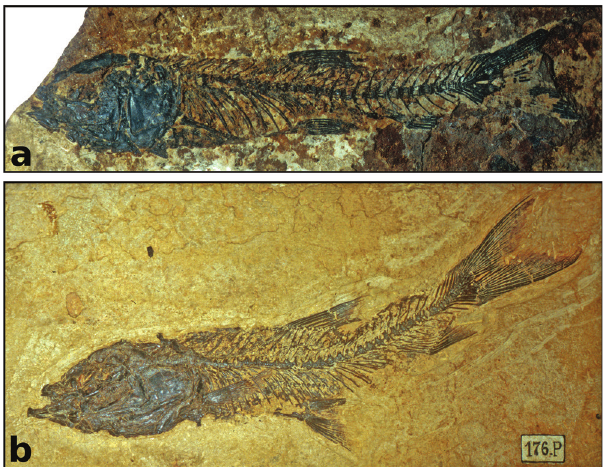
Fig. 2 . a . Dastilbe moraesi , DGM 593-P, 47.0 mm SL, holotype, Fazenda São José do Geribá, Presidente Olegário, State of Minas Gerais, Brazil; b . Dastilbe crandalli , DGM 176-P, 153.6 mm SL, holotype of Dastilbe elongatus , Brazil, State of Ceará, Sítio Romualdo, 15 km from Crato, coll. C.